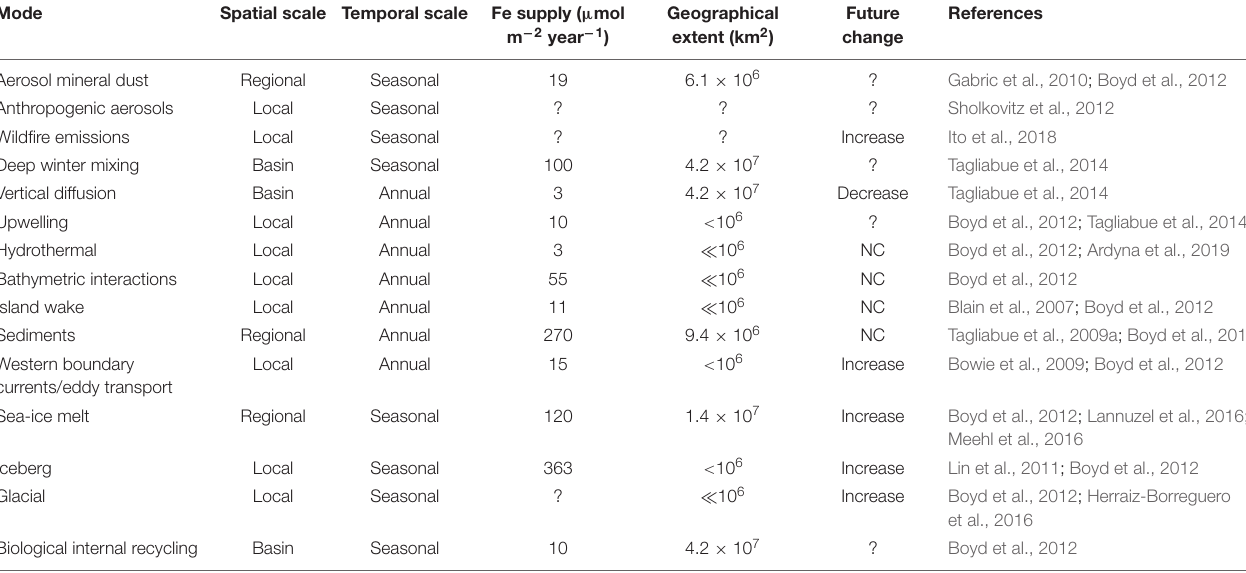
Table adapted and augmented from Hutchins and Boyd (2016). ? = unknown supply or extent; uncertain direction of change. NC = no change expected.